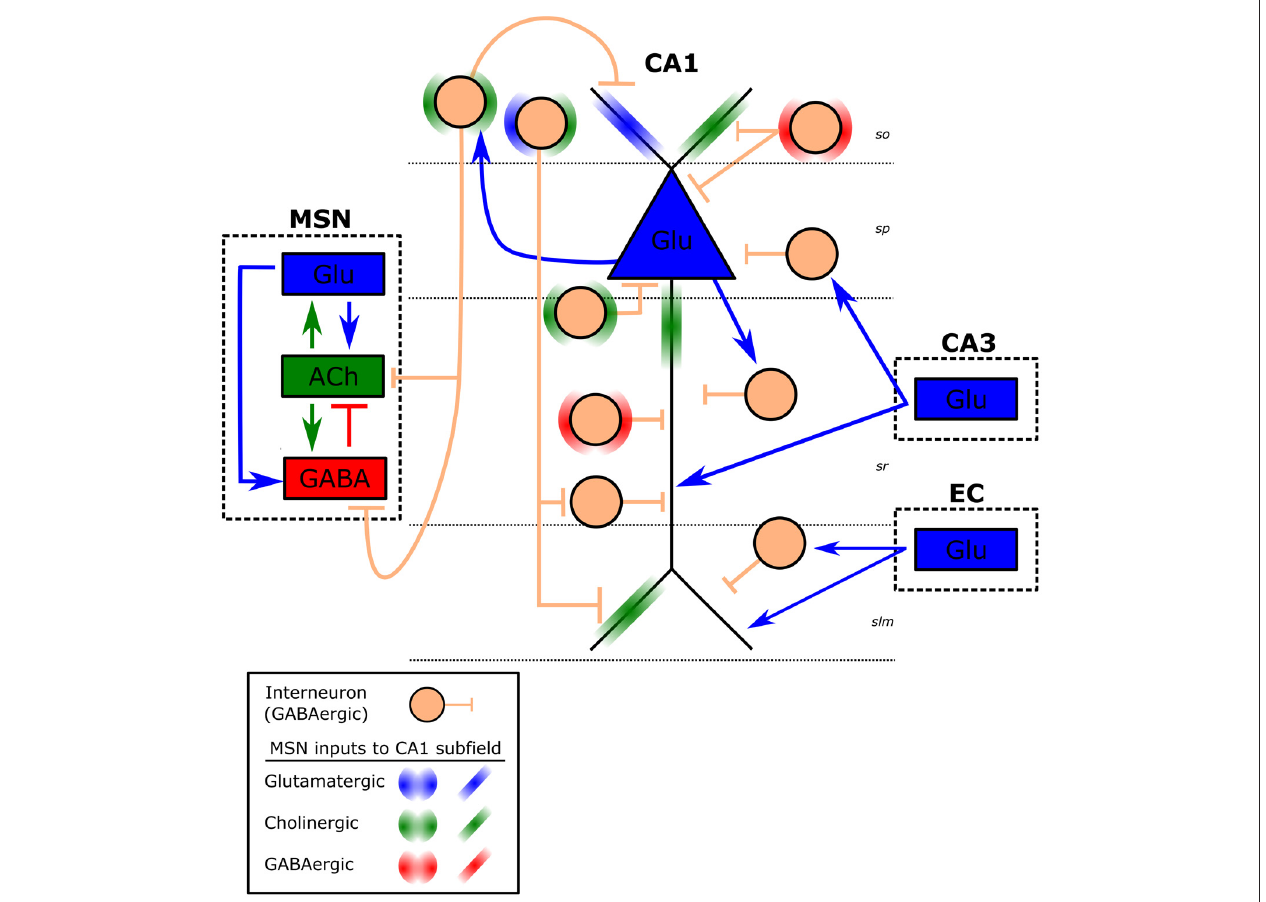
FIGURE 1 | Schematic of CA1 theta generators. Illustrated is a CA1 pyramidal cell (blue triangle) and hippocampal GABAergic interneurons (peach circle) within each CA1 layer. Approximate CA1 layers are indicated by dashed horizontal lines (so, stratum oriens; sp, stratum pyramidale; sr, stratum radiatum; slm, stratum lacunosum-moleculare). Interneurons within each layer represent a subclass of interneurons (e.g., O-LM, PV basket, axo-axonic) for that layer, which receive different inputs and have distinct projections (e.g., back projecting). Dashed boxes represent CA1 inputs from medial septal nucleus (MSN), entorhinal cortex (EC) and the CA3 subfield. Arrows represent excitatory (blue-Glu: glutamate, green: ACh- acetylcholine), whereas short vertical lines are inhibitory (red and peach: GABA) connections. Projections from the MSN are left out for clarity and are represented by halos (circular on interneurons, linear on CA1 pyramidal